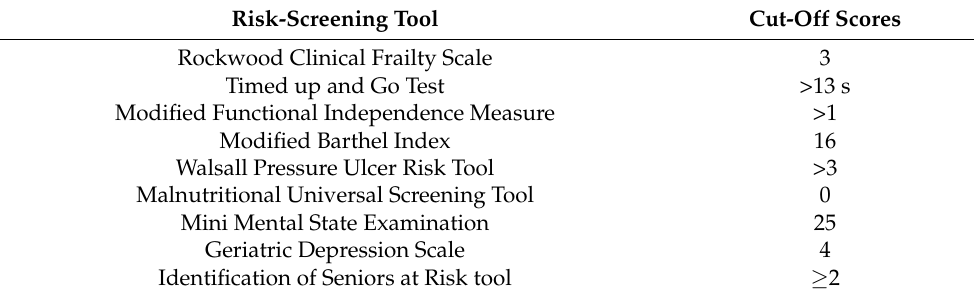
Table 4. Risk-screening instruments used in the Community Virtual Ward model to predict outcomes and cut-off